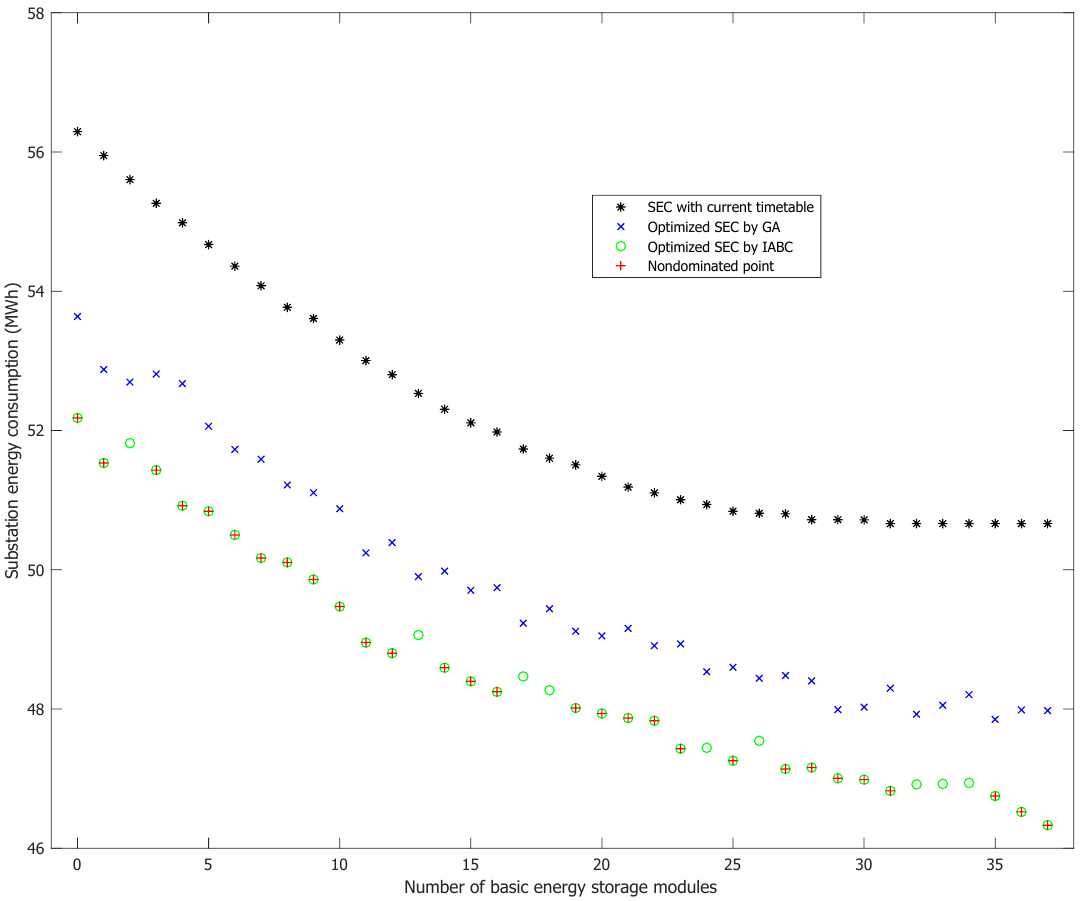
Figure 7. Traction energy saved in different numbers of basic energy storage